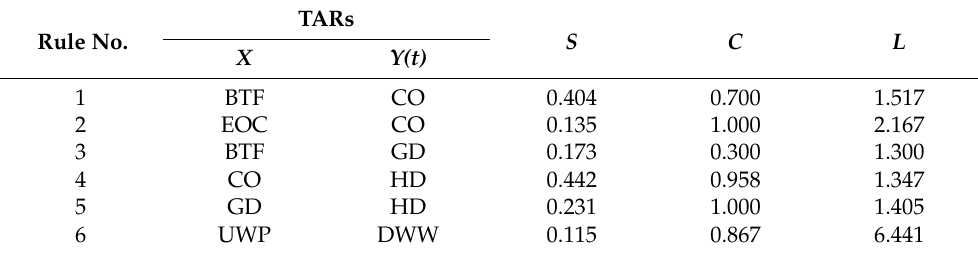
Table 5. TAR results for container ships.